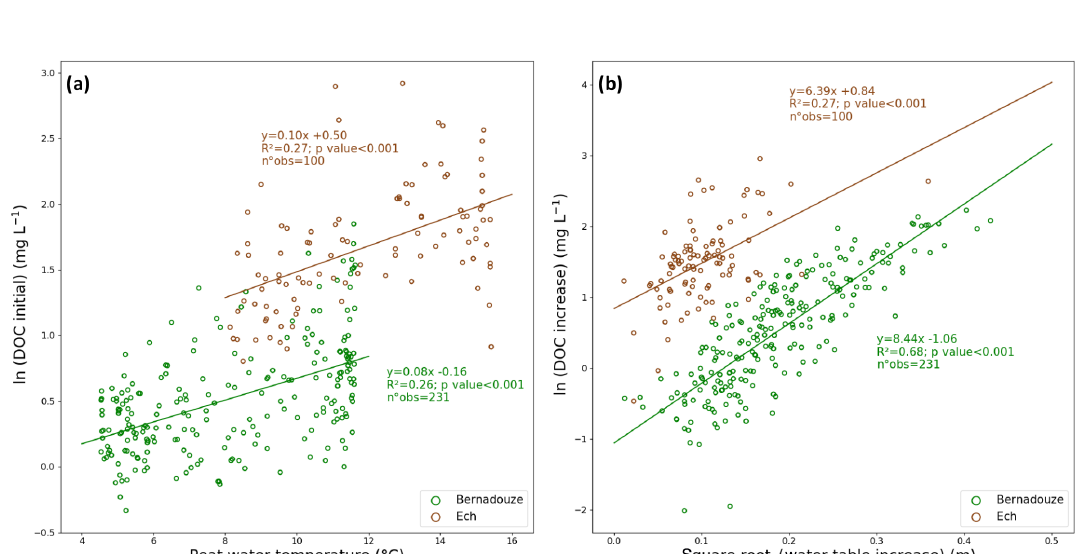
Figure 4. Relationships between (a) peat water temperature and natural logarithm of DOC concentration initial value and (b) square root of water table increase and natural logarithm of DOC concentration increase during peak events at Bernadouze (green) and Ech (brown). Regression coefficients (intercept and slope), p values and R 2 are given in each